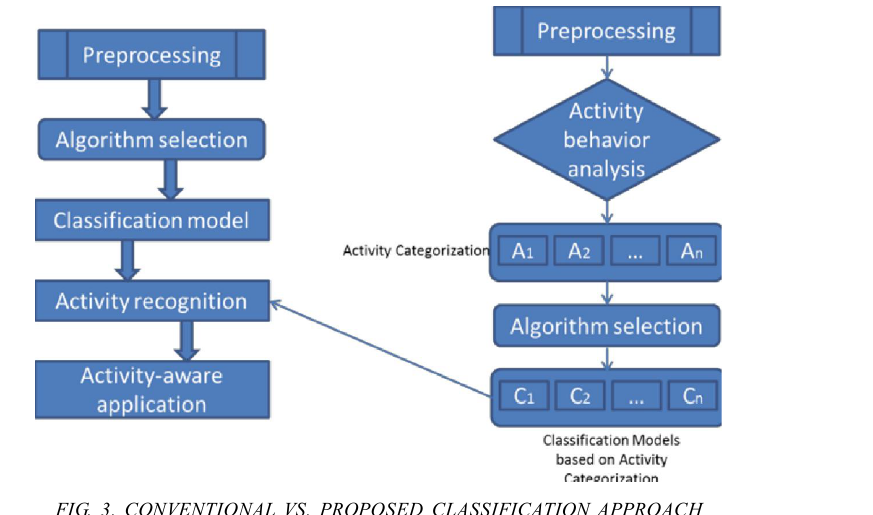
FIG. 3. CONVENTIONAL VS. PROPOSED CLASSIFICATION